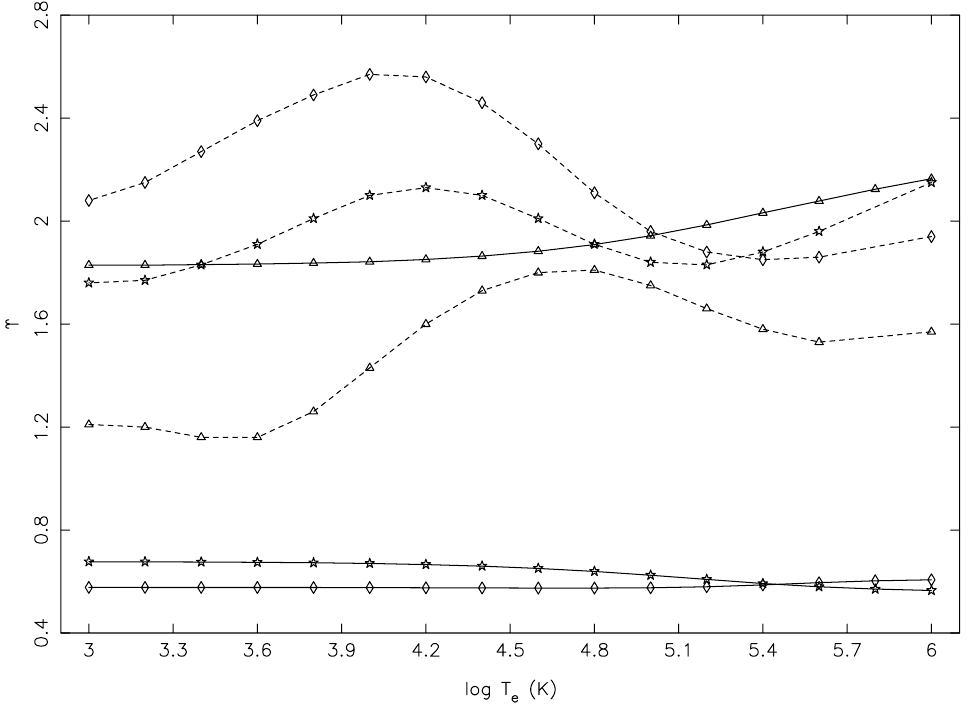
Figure 8. Comparison of FAC and BSR values of Υ for the 4–5 (triangles: 3p 2 1 D 2 –3p 2 1 S 0 ), 20–25 (diamonds: 3p3d 3 P o –3p3d 3 D o ), and 20–27 (stars: 3p3d 3 P o –3p3d 3 D o ) transitions of S III. Continuous 3 1 1 1 curves present results with FAC; broken curves are the earlier results of Tayal et al. [1] with BSR.